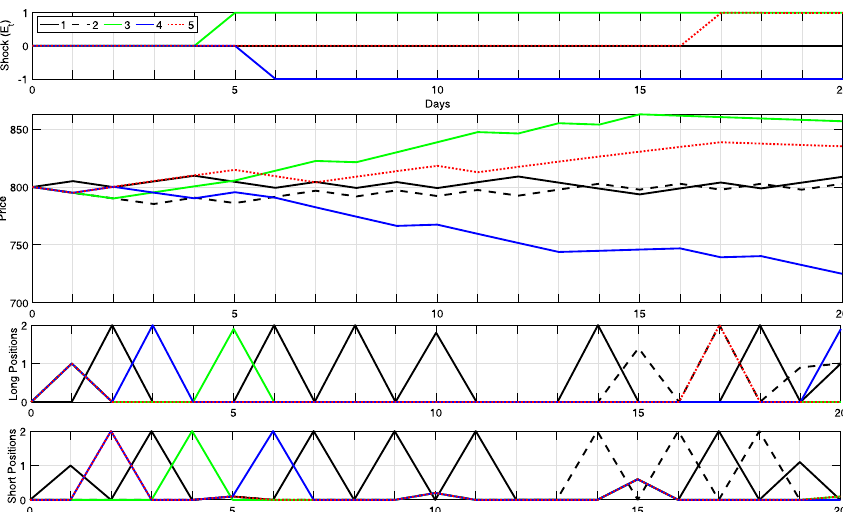
Fig. 6 RN solution for 5 representative scenarios in a daily trading setting, with the following income structure: f 1 positions bounded by L